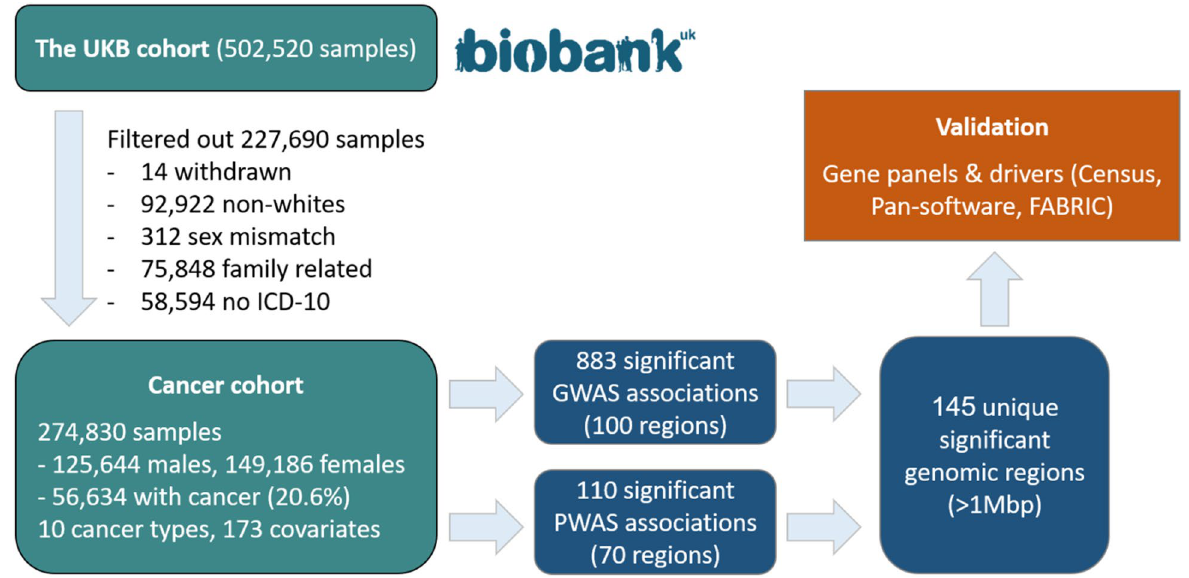
Figure 2. Analysis workflow. From the UK Biobank cohort (~ 500 K individuals), we derived a study cohort of 274,830 individuals. Based on their medical records, we determined whether each of the individuals had a history of cancer, focusing on nine major cancer types and pan-cancer which combines individuals with any cancer (56,634 overall). We used two statistical methods, standard GWAS and PWAS, over each of the ten cancer types, and found 883 variant-cancer and 110 gene-cancer significant associations, respectively. We merged the significant associations into 145 unique genomic regions (of at least 1,000,000 base pairs each), and validated the regions by comparing them with prominent gene panels used in the clinics and catalogues of cancer driver genes.